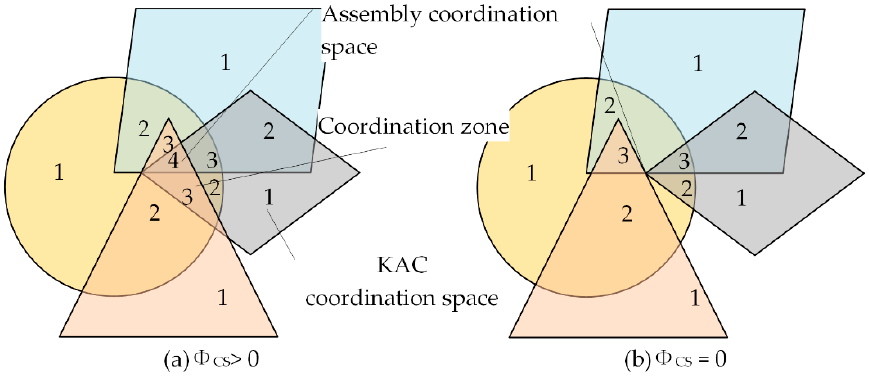
Figure 6. The relationship between the part and feature PFS.